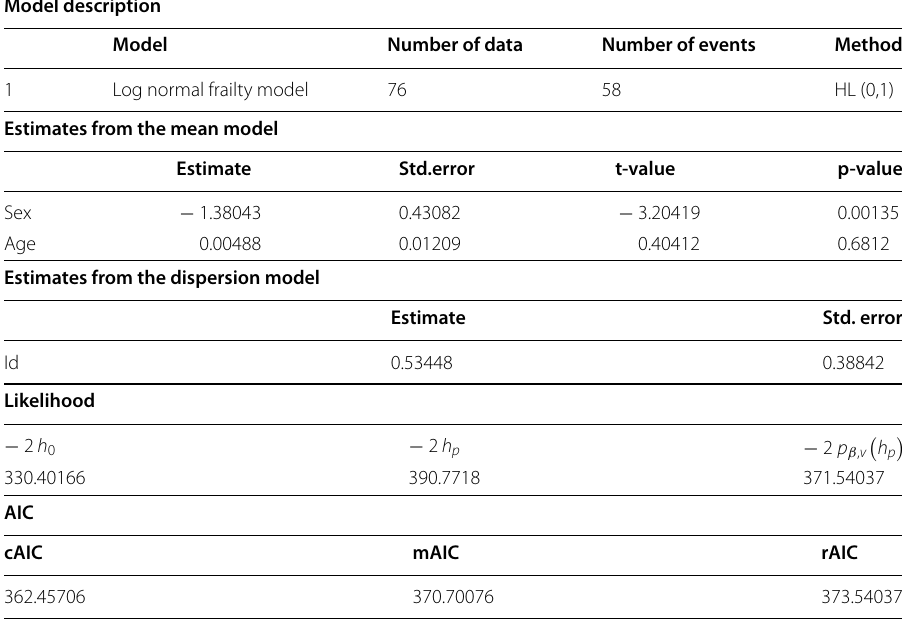
Table 7 Model description FOR LOG‑normal